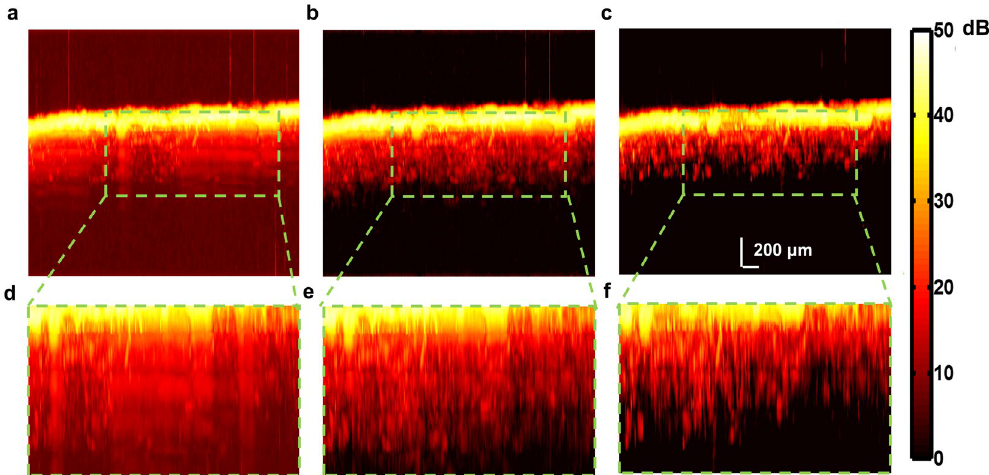
Figure 7. XZ projection PAM image of mouse cortical vasculature ( a ) Using raw signal ( b ) Applying correlation window directly to B-scans ( c ) Applying correlation window to dictionary learned from B-scans. Reverberation is suppressed but cortical vessels are more clearly delineated when the window is applied to the dictionary as seen in corresponding zoomed insets ( d – f ).